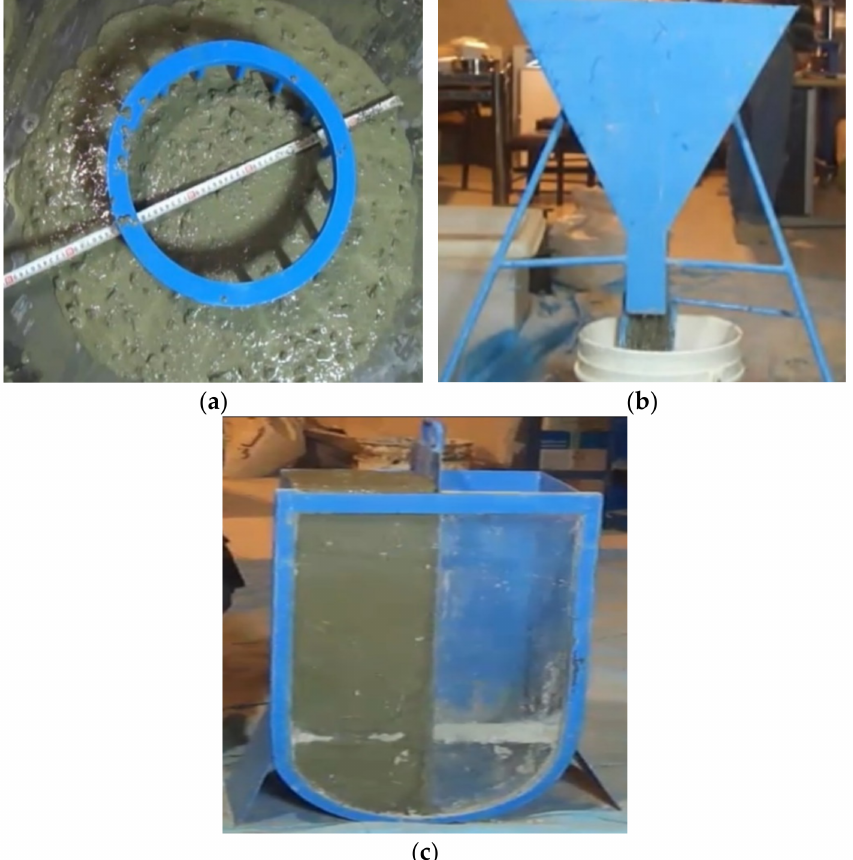
Figure 1. Various test methods: ( a ) J-ring test; ( b ) V-funnel test; ( c ) U-box